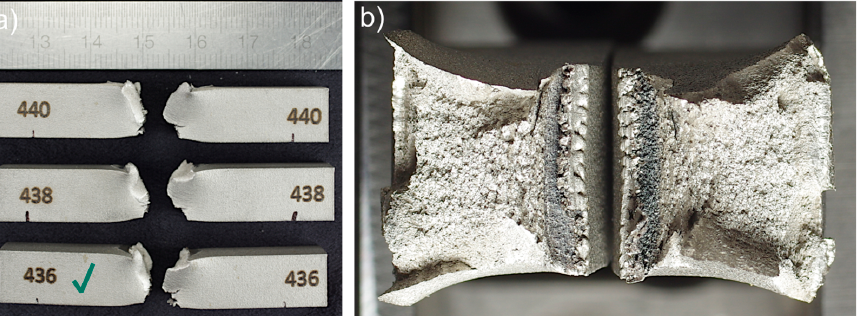
Figure 17. Fractures of Charpy test EOS M 290 specimens presented as: ( a ) fractured Charpy EOS M 290 specimens; ( b ) fracture surface (optical microscope image) of the EOS M 290 316L, specimen 436. The samples have been numbered, which are visible in the figure. The letters L and R stand for the left-hand and right-hand sides of the sample in the figure. A green check mark means the specimen whose fracture faces were shown.